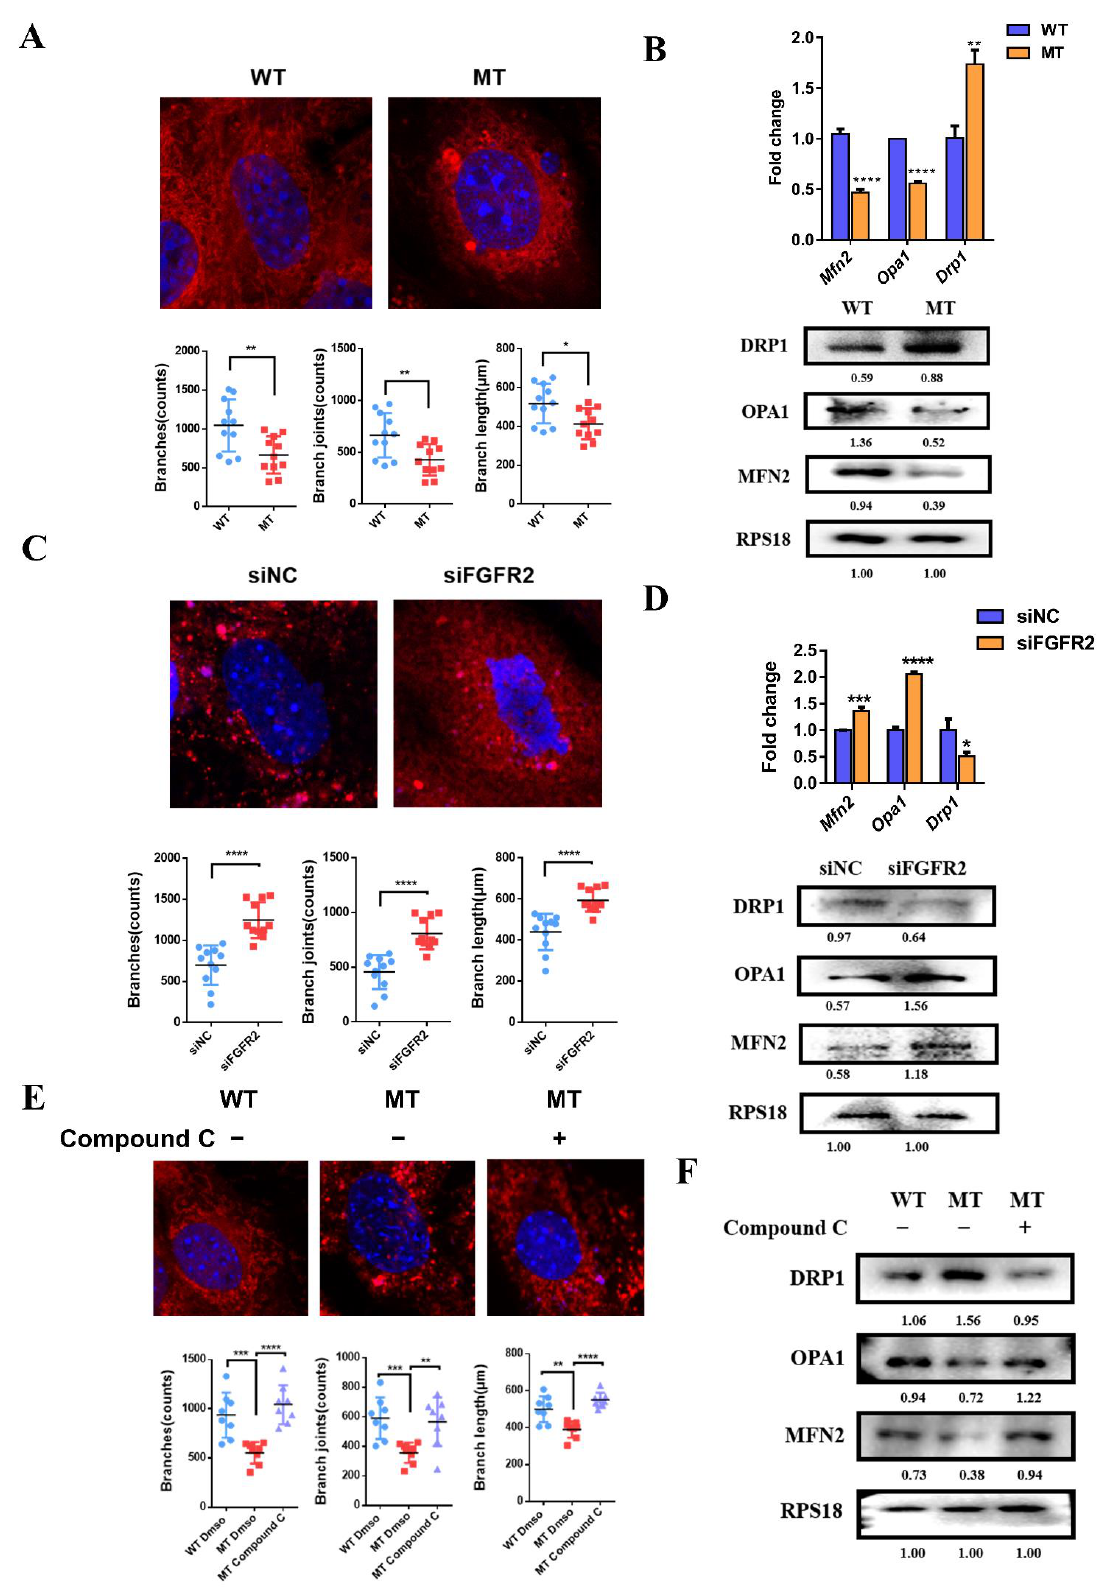
Figure 7. Mitochondrial dynamics participate in osteogenesis mediated by FGFR/FGFR2-AMPK pathway: ( A ) Mito-tracker red and mitochondria 2D analysis showed more fragmented or punctate mitochondria with fewer and shorter branches in the MT group, while there were widely